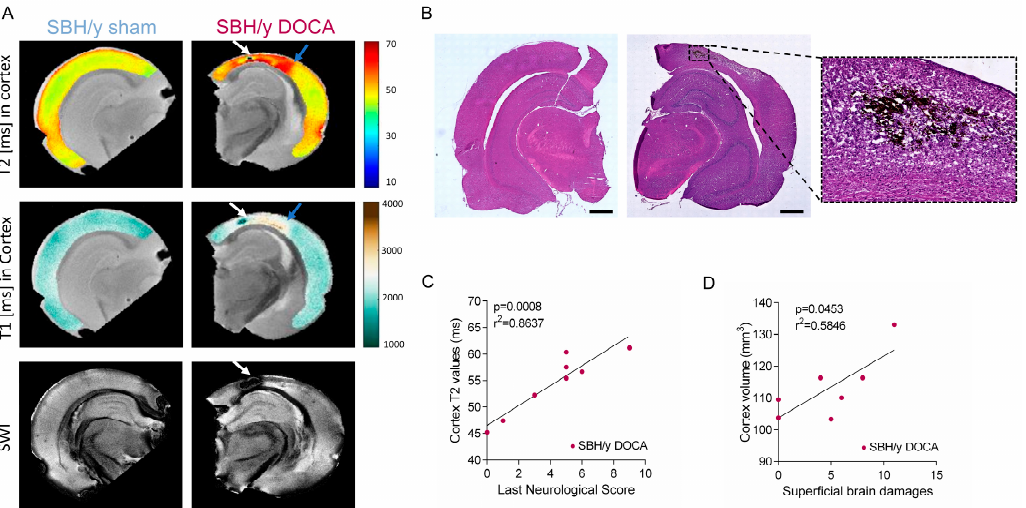
Figure 2. MRI correlates brain pathology in SBH/y-DOCA rats. Representative T2-weighted (top panel), T1-weighted (middle panel) and SWI (bottom panel) images of SBH/y sham ( n = 5) and SBH/y-DOCA ( n = 9) rats ( A ). White arrows indicate ICH, and blue arrows indicate fluid-filled cavities. Correlative H&E-DAB staining of brains is shown in ( A ) and 10 × magnification of the injured area ( B ). Correlation between cortical T2 values and last neurological score in SBH/y-DOCA rats ( n = 9) ( C ). Correlation between cortical volume and the amount of obvious brain damage in SBH/y-DOCA rats ( n = 9) ( D ). Scale bar = 1 mm. Pearson correlation in ( C , D